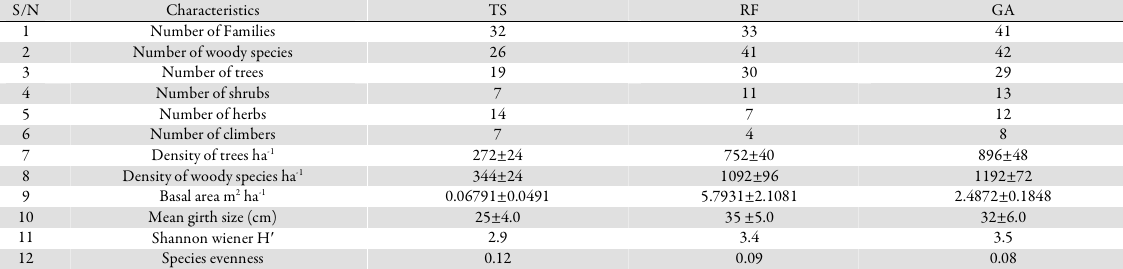
Tab. 3. Summary characteristics of floristic composition and structure of the Shasha forest